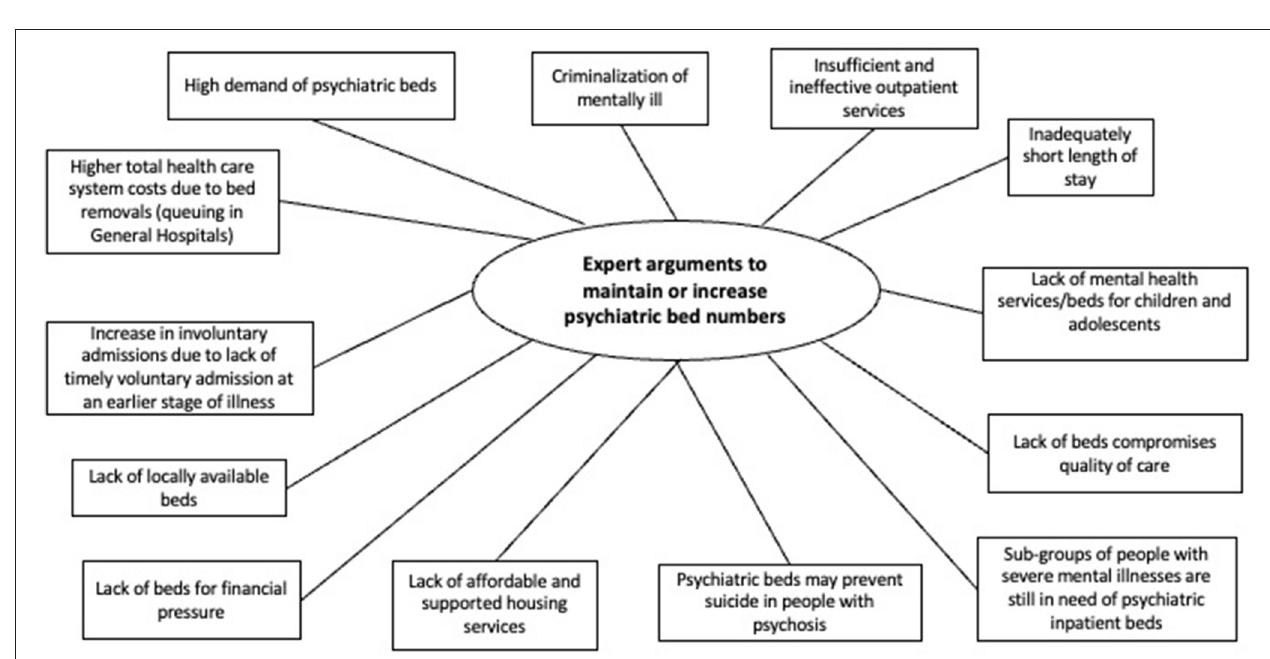
FIGURE 2 | Expert arguments to reduce psychiatric bed numbers, a systematic review of qualitative data.